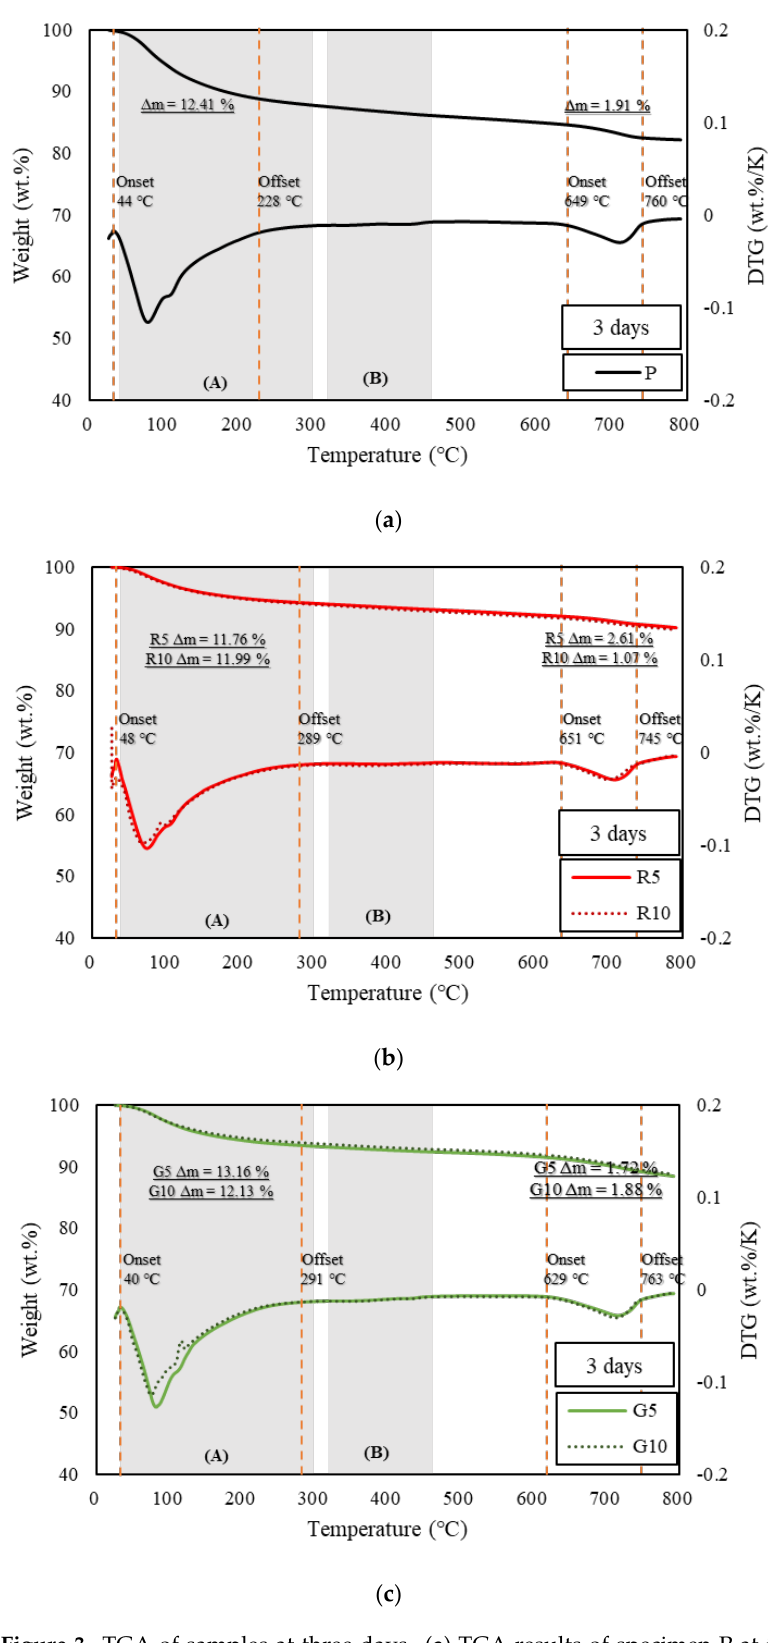
Figure 3. TGA of samples at three days. ( a ) TGA results of specimen P at the age of three days, ( b ) TGA results of specimens R5 and R10 at the age of three days, and ( c ) TGA results of specimens G5 and G10 at the age of three